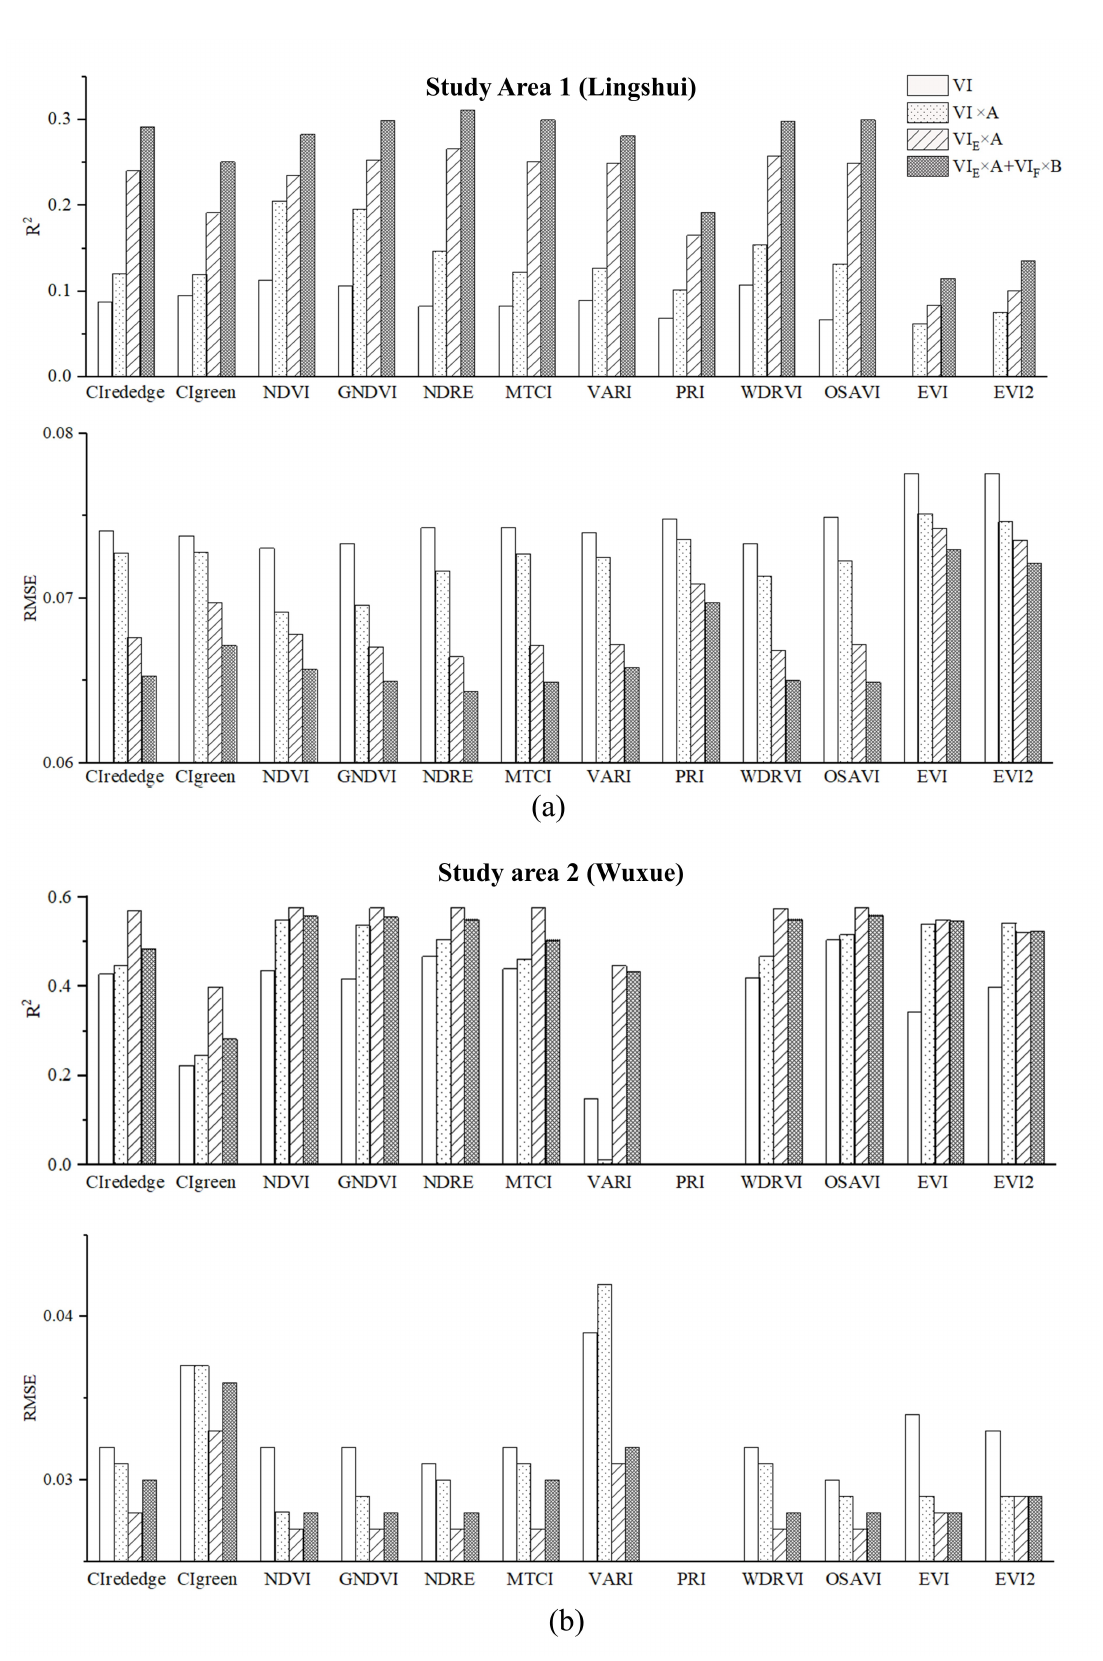
Figure 11. The R 2 and RMSE of yield with VI, VI × A, VI E × A, and (VI E × A + VI F × B) of ( a ) Study Area 1 Lingshui and ( b ) Study Area 2 Wuxue at heading